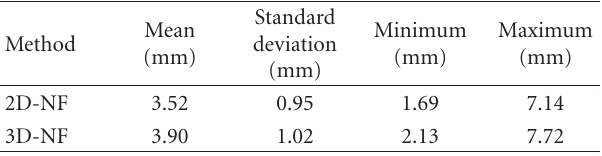
Table 1: Comparison of nuchal fold thickness measurements by two- and three-dimensional ultrasonography methods.